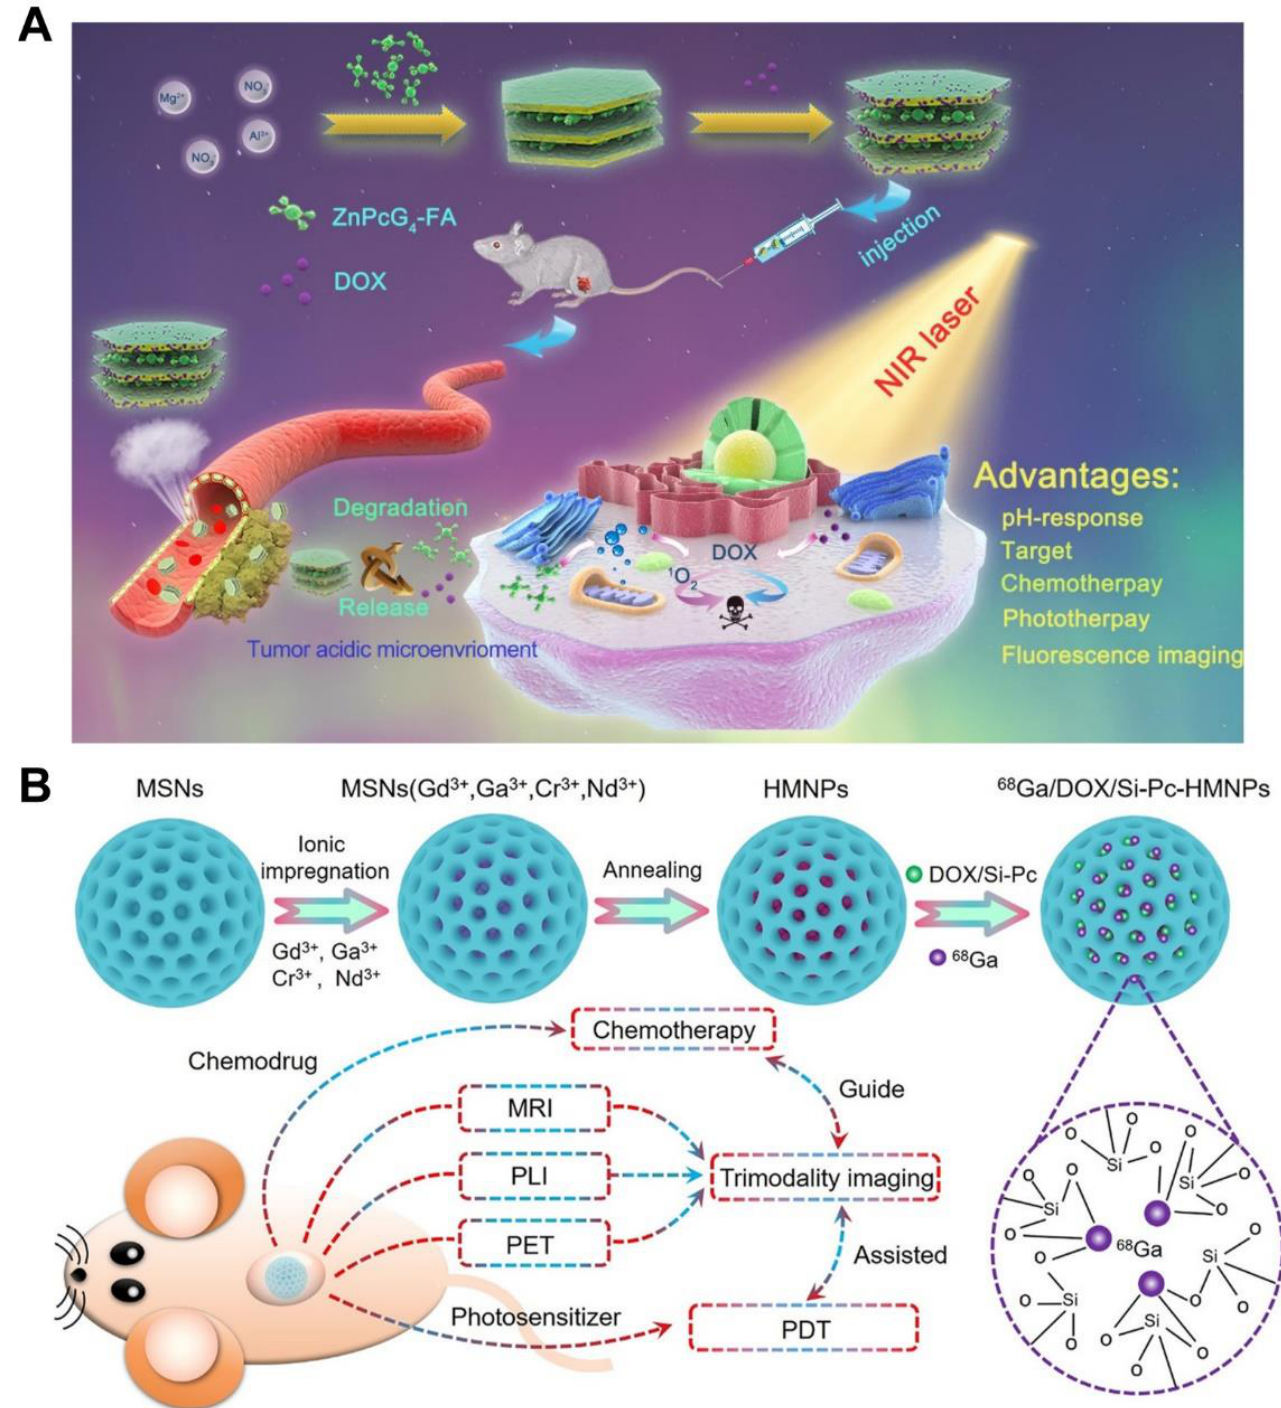
Figure 5. Preparation of high drug-loading nanomedicines by inorganic nanoformulas for chemo– photodynamic combination therapy of tumors. ( A ) Schematic illustration of the synthesis and antitumor performance of LDH_ZnPcG 4 -FA/DOX nanoplatform [91]. ( B ) Schematic illustration for the synthesis of 68 Ga/DOX/Si-Pc-Loaded HMNPs [92]. Reprinted with permission from Ref. [91]. Copyright 2020, Elsevier. Reprinted with permission from Ref. [92]. Copyright 2021, American Chemical